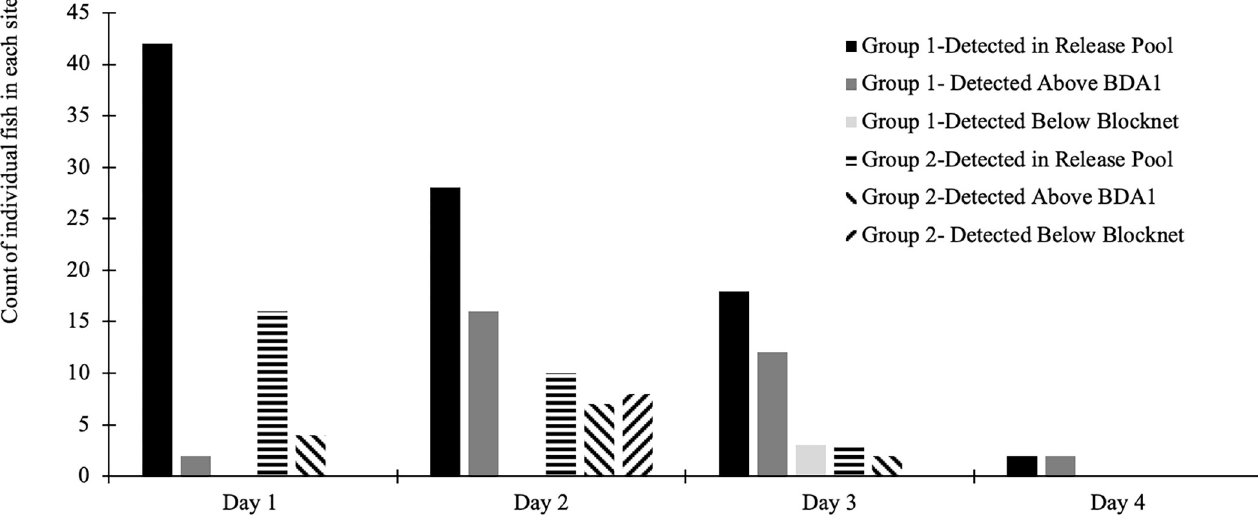
Fig 5. Daily PIT antenna detections of juvenile steelhead trout above and below BDA in 2016. The 2016 experimental release of juvenile steelhead trout below BDA 1 on two consecutive days showing the daily number of detections of individual steelhead trout for each release group in the release pool below BDA 1, in the Pond above BDA 1, and below the block net at the lower end of the release pool. Thirty two fish were released in the first cohort on 9/30/16 and 16 more in the second cohort on 10/1/16, for a total of 58 fish released. Day 1 refers to the day of release for each cohort, Day 2, the day after release, etc.